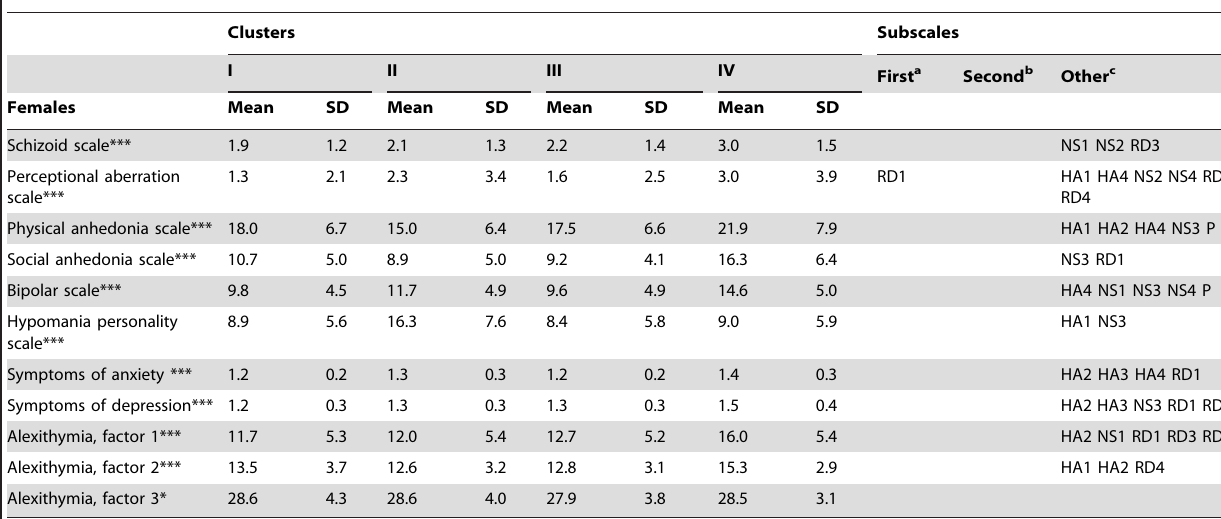
Table 6. Psychological scales for males.